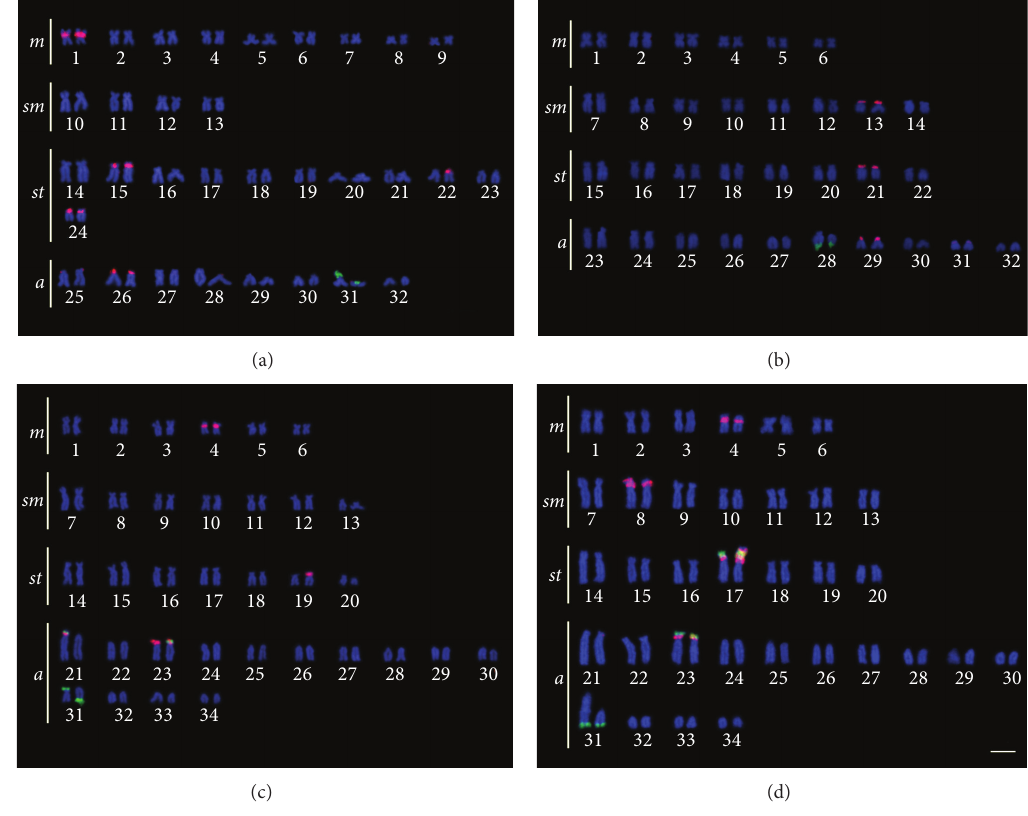
Figure 1: Double FISH karyotypes with 5S rDNA probes (rhodamine, red) and 18S rDNA probes (FITC, green) of (a) Hypostomus faveolus ; (b) Hypostomus cochliodon ; (c) Hypostomus commersoni from the Piquiri River and (d) Hypostomus commersoni from the Iguac¸u River. The bar represents 5 𝜇